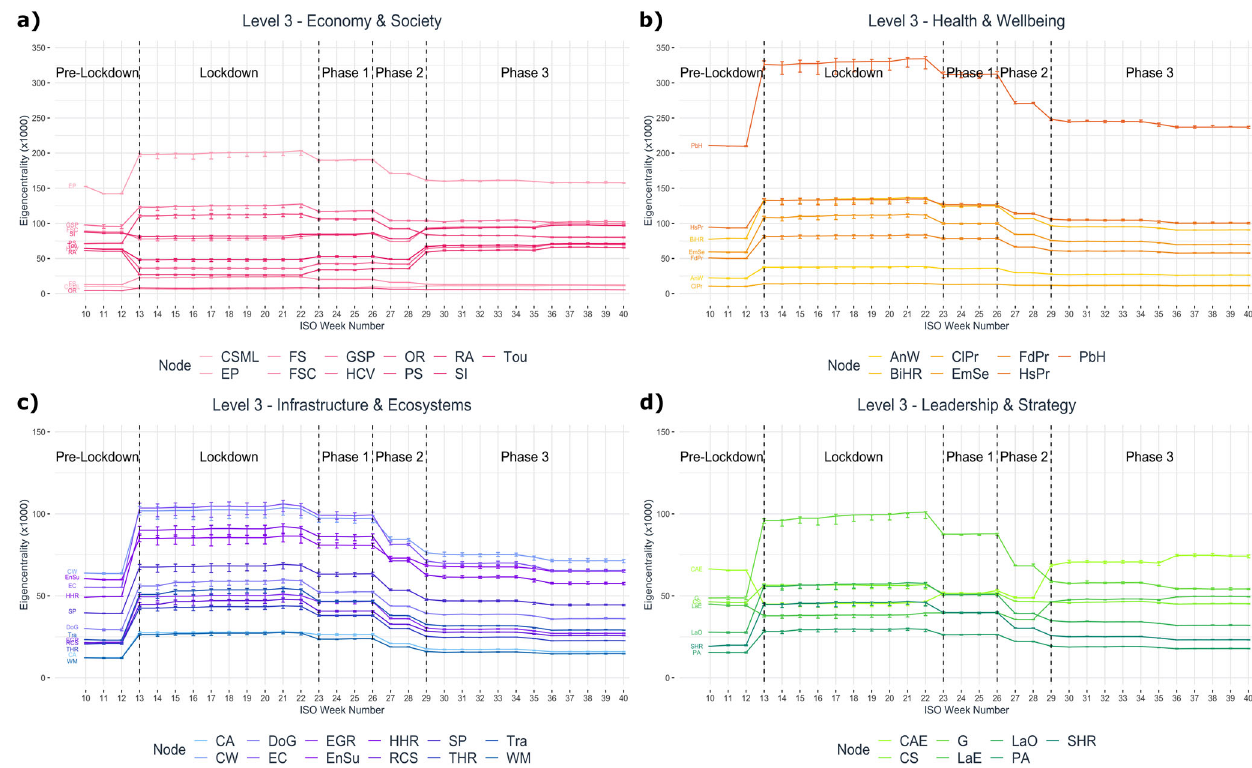
Fig. 8 Time series of eigenvector centrality (EC) values nodes (EC con fi dence included – see “ Methods ” section) at the Tasks level, throughout the modelled period. Time series in the a economy & society category, b health & wellbeing category, c infrastructure & ecosystems category, d leadership & strategy category (for full node names and abbreviations see Fig. 9 or Table